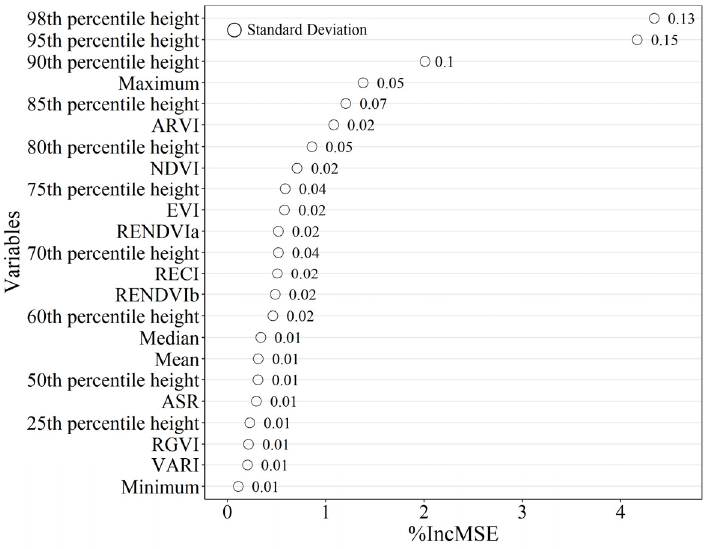
Figure 5. Importance ranking (with standard deviation) of the ASR and height metrics obtained using random forest.